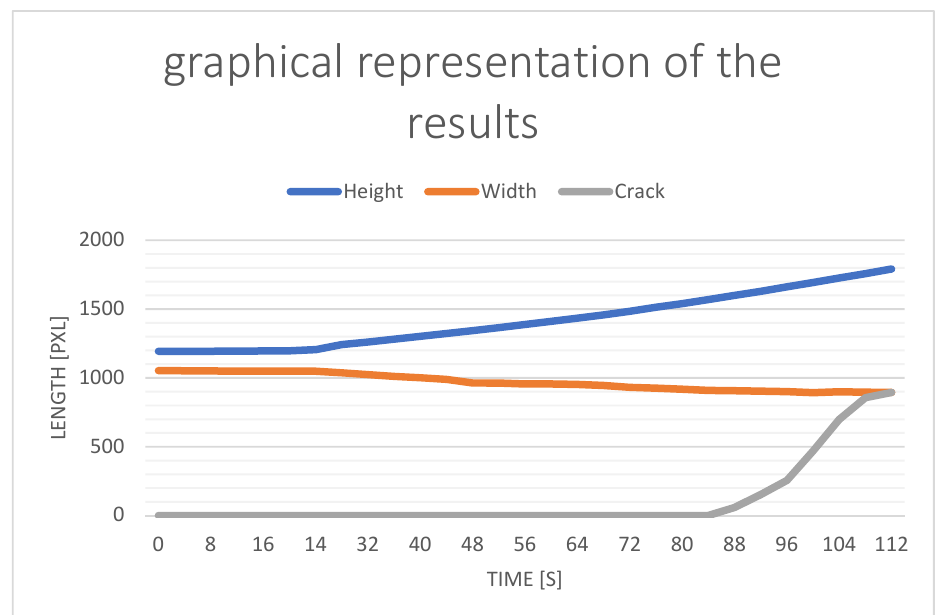
Figure 12. Graphical representation of the results.